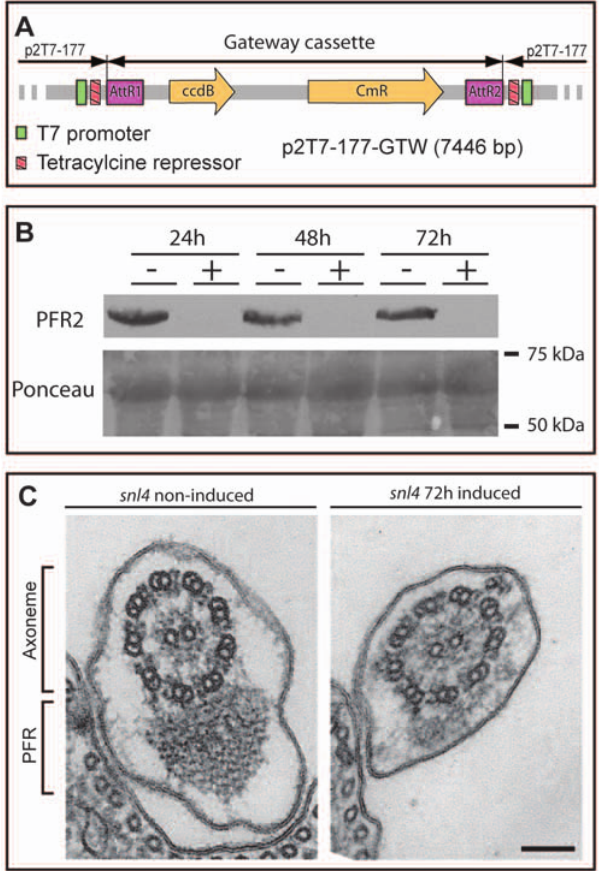
Figure 2. A Gateway H compatible vector for RNAi analysis in T. brucei . A. p2T7-177-GTW. The Gateway H cassette containing the chloramphenicol resistance gene and the toxic ccdB gene was inserted into the inducible expression site of the p2T7-177 plasmid. B. Western blotting analysis of whole cell lysates of snl4 (procyclic form T. brucei containing p2T7-177-GTW-PFR2) over an RNAi induction time course. PFR2 protein (visualised with L8C4 antibody) is undetectable after 24 hours of RNAi induction. Ponceau stained membrane is shown as a loading control. C. Transmission electron micrographs of non-induced and 72 hour induced snl4 flagellar cross-sections reveal the absence of a large part of the PFR structure. Bar 100 nm.